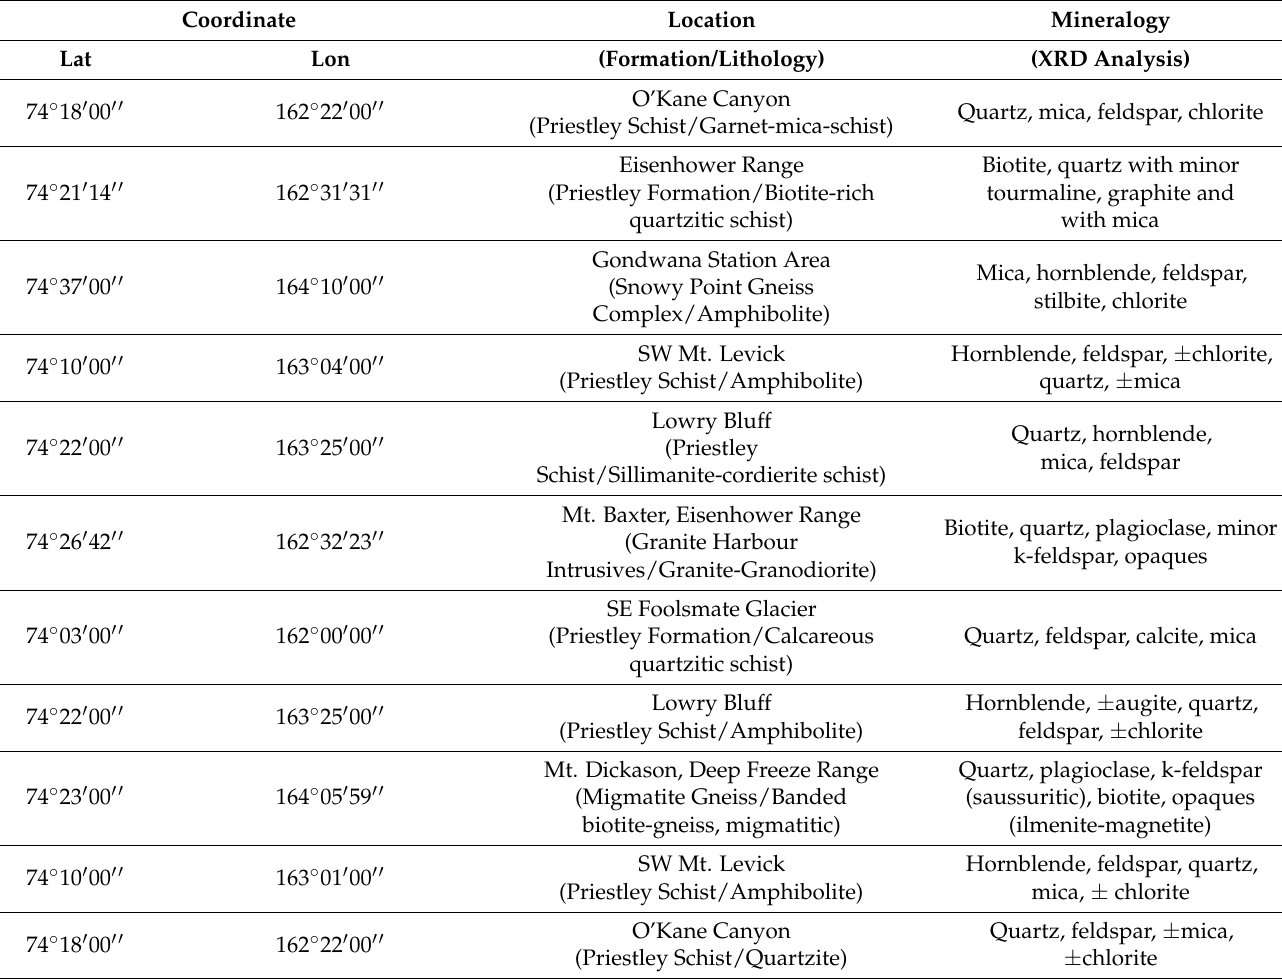
Table 5. Location of selected GPS points and mineral components derived from XRD analysis for representative altered rock samples. Coordinate Location Mineralogy Lat (Formation/Lithology) (XRD